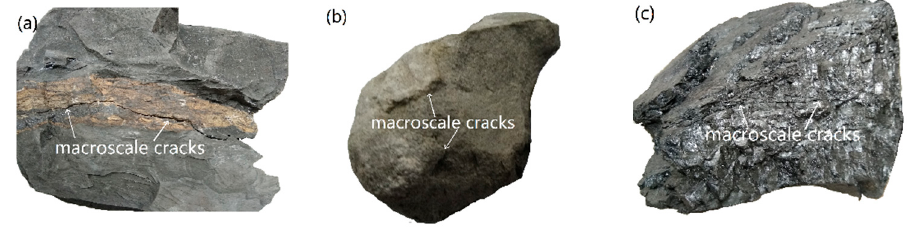
Figure 2. Photos of ( a ) Sample #1, ( b ) Sample #2 and ( c ) Sample #3.